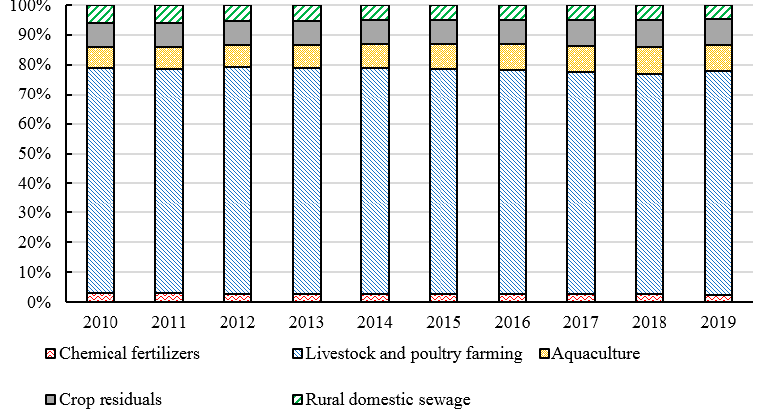
Figure 2. The proportion of TN emissions from different sources from 2010 to 2019.